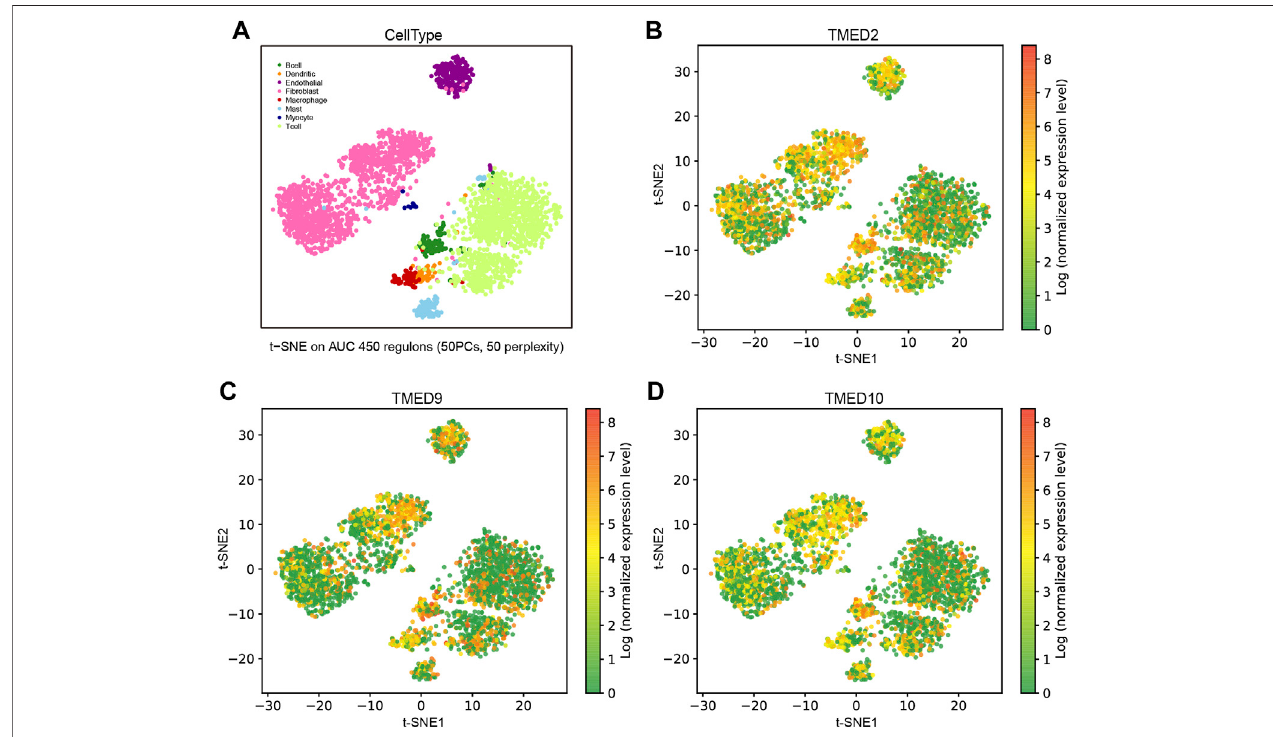
FIGURE 7 | Expression analysis and single-cell analysis of genes TMED/2/9/10 in HNSC. (A) Distinguishing TMED2/9/10 enrichment and expression levels in different cell types of HNSC based on single-cell data. The t-SNE plots showed the expression levels in each cell of HNSC of (B) TMED2, (C) TMED9, and (D) TMED10.